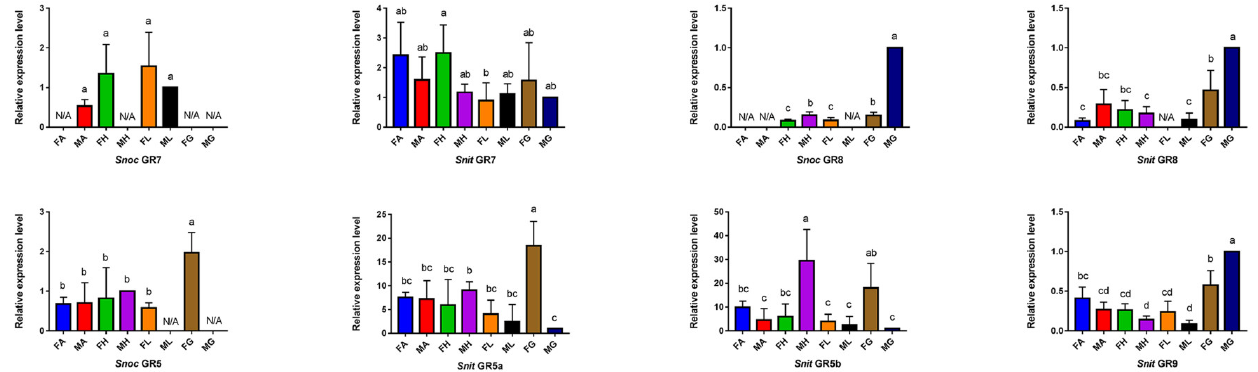
Figure 8. Relative expression levels of S. noctilio and S. nitobei GRs in different tissues of female and male adults by qPCR. FA: female antennae; MA: male antennae; FH: female head; MH: male head; FL: female legs; ML: male legs; FG: female genitals; MG: male genitals. The bar represents standard error and the different small letters (a–e) above each bar indicate significant differences ( p < 0.05). N/A indicates that the transcript level is too low to measure.